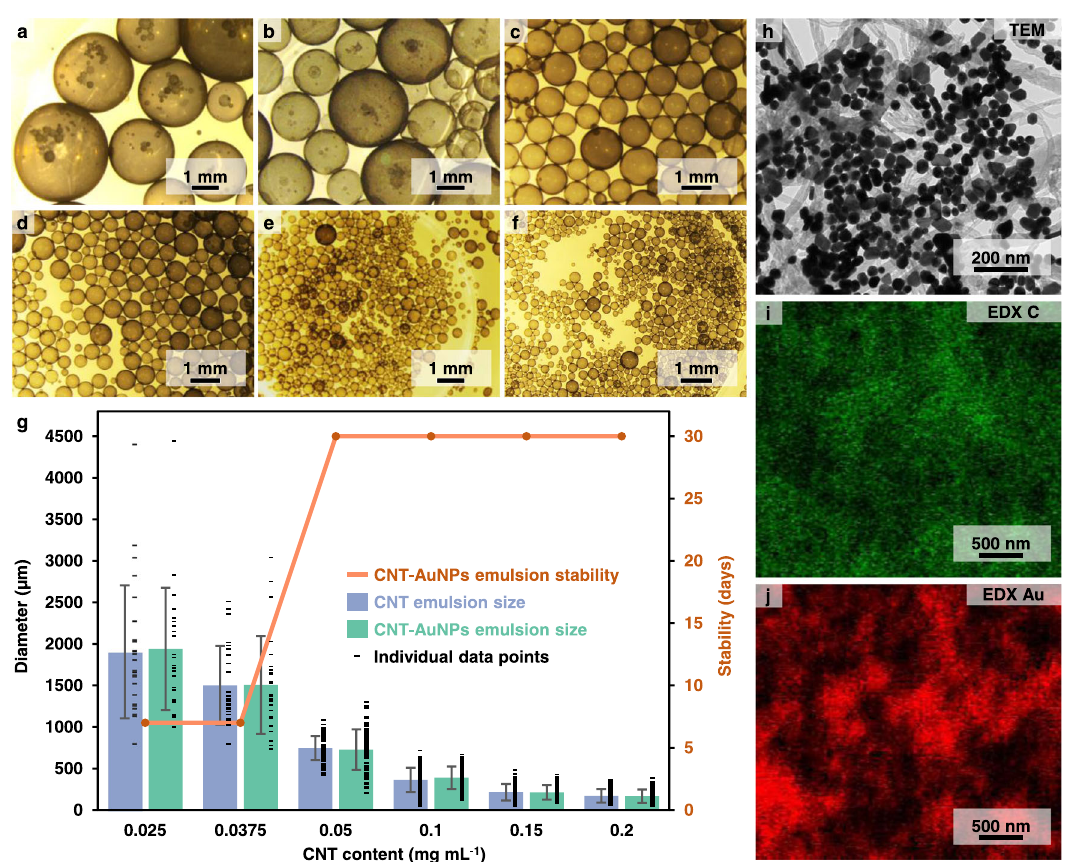
Fig. 3 | Characterization of CNT-AuNP emulsions. a – f Optical images of typical batches of CNT-AuNP emulsions formed with 0.025, 0.0375, 0.05, 0.1, 0.15, and 0.2mgmL − 1 ofCNTs,respectively. g Plotcomparingtheaveragesizeandstabilityof theemulsionsversustheamountofCNTsused.Thestandarddeviationforsamples with a CNT content of 0.025 and 0.0375 were calculated from N =25 individual emulsion droplets. The standard deviation for samples with a CNT content of 0.05 were calculated from N =80 individual emulsion droplets. The standard deviation